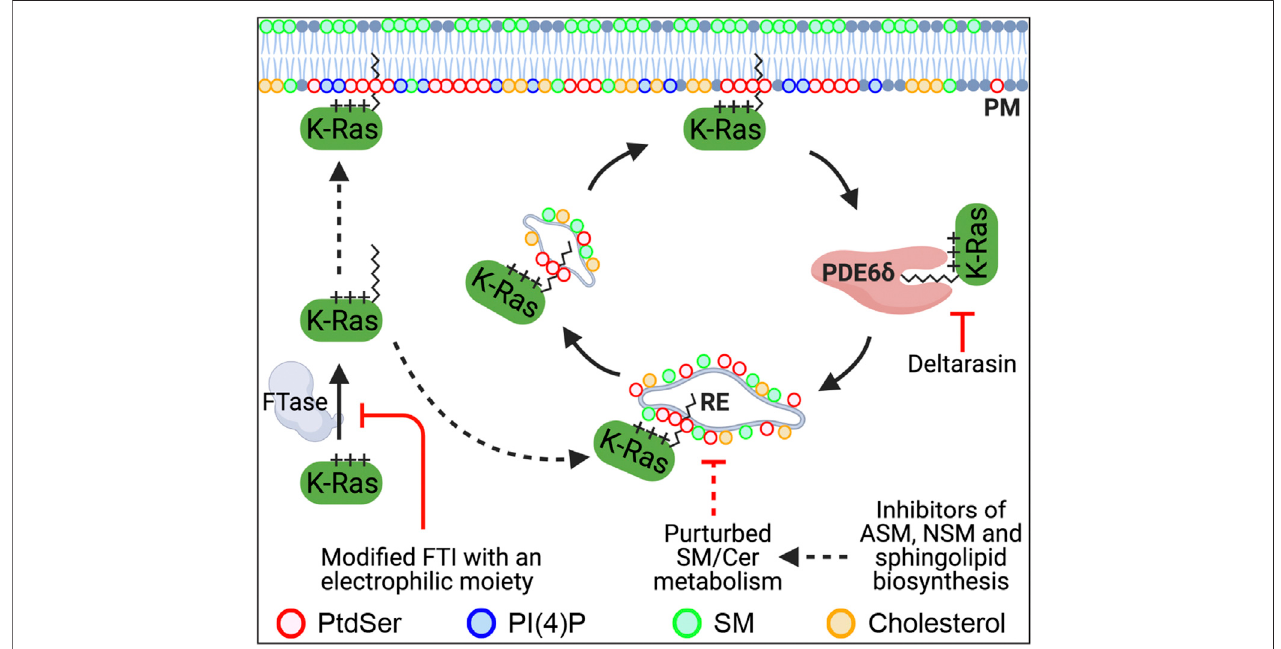
FIGURE 1 | Recently identi fi ed molecular mechanisms that regulate the PM localization of K-Ras. K-Ras farnesylated by FTase localizes to the PM. Once K-Ras dissociates from the PM, PDE6 δ binds K-Ras via its farnesyl moiety and releases it in the perinuclear region. K-Ras is then translocated to the recycling endosome (RE) throughelectrostaticinteraction,whereitreturnstothePM via RE-mediatedvesiculartransport.BlockingK-RasprenylationortheK-Ras/PDE6 δ interactionmislocalizes K-Ras from the PM. Perturbed SM/ceramide metabolism is proposed to dysregulate the RE via altering its lipid composition, resulting in depletion of PtdSer and K-Ras from the PM. FTase, farnesyltransferase; FTI, FTase inhibitor; PDE6 δ , phosphodiesterase 6 δ ; RE, recycling endosome; PtdSer, phosphatidylserine; SM, sphingomyelin; Cer, ceramide; PI4P, phosphatidylinositol 4-phosphate; ASM, acid sphingomyelinase; NSM, neural